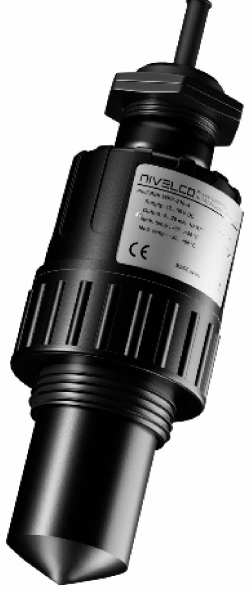
Figure 2. Standard level meter